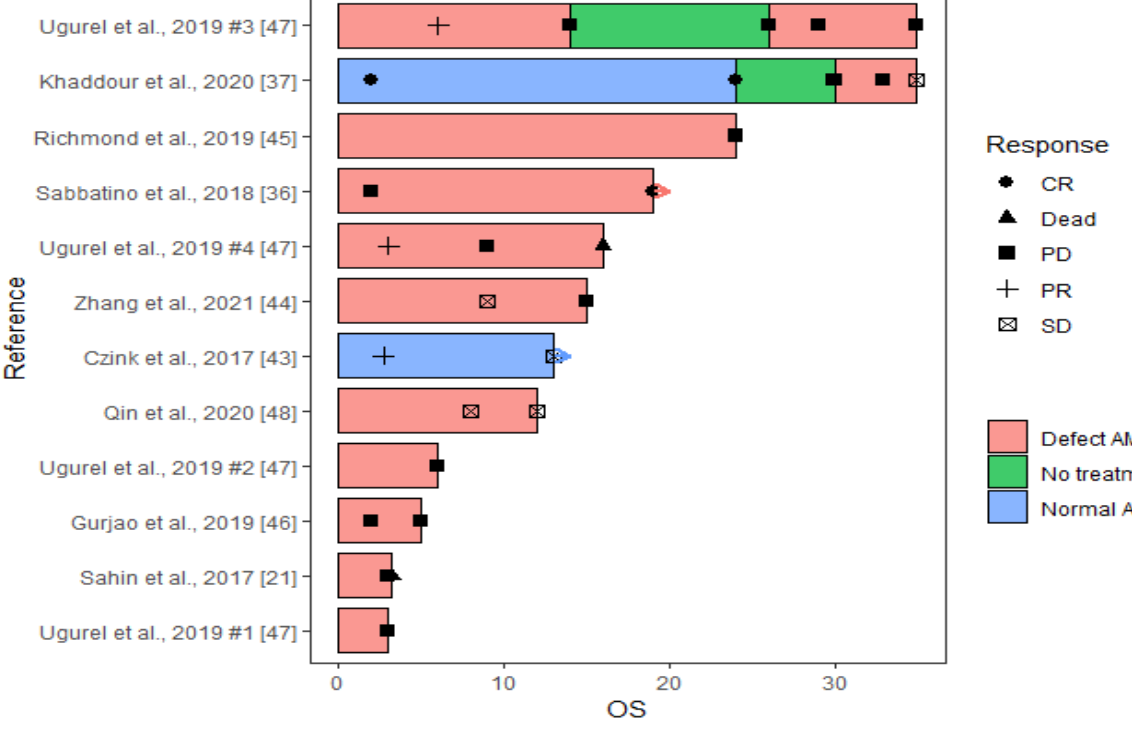
Figure 5. Swimmer plot of the 12 cases from the 9 case studies included. ICI therapies given as combinations or consecutive were merged as one treatment. Only PFS and OS time (months) are included in the plot, i.e., only time during ICI therapy. Hence, the initial response observed in the case from Sahin et al. [21], or the CR observed in Khaddour et al. [45] after removal of ICI drugs are not included. Arrows indicate that the ICI treatment is continued. A detailed description follows for complex cases. For Ugurel et al.[50], the four cases are referred to by #. For Ugurel et al., 2019 case #3, ICI treatment was terminated after tumor excision and the patient was followed with computed tomography until relapse after 12 months where ICI treatment was reinitiated. For Khaddour et al.[45], CR was observed after 2 months, and maintenance therapy was continued for 2 years. After 6 month the patient experienced a recurrence and treatment was reinitiated. After continued pro- gressive disease, a B2M mutation was discovered, and ICI therapy was terminated after 5 months. The patient was then switched to chemotherapy. For Zhang et al. [47], ICI treatment was ended due to immune-related adverse events.